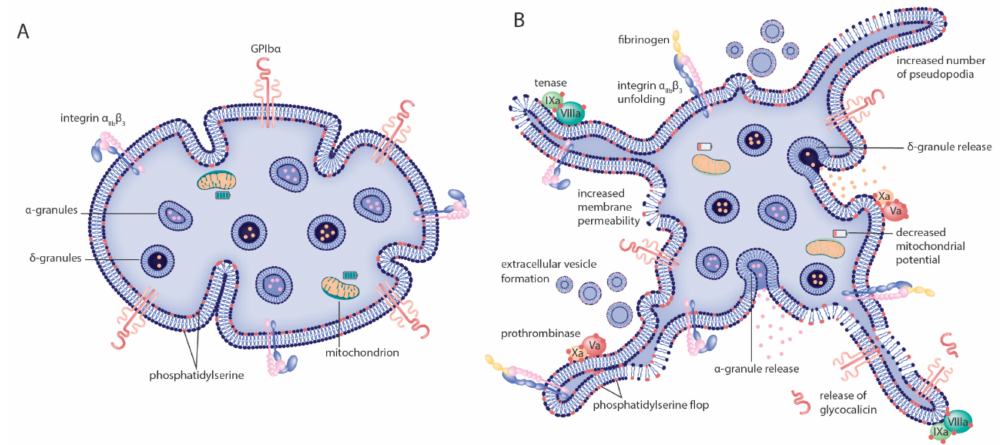
Figure 1. Morphologic and biochemical changes to platelets after cryopreservation. The model indicates known morphologic and biochemical changes to platelets going from ( A ) resting, healthy cells before cryopreservation to ( B ) altered phenotype after cryopreservation. Morphologic alterations induced by cryopreservation include a significant shape change from discoid to spherical platelets and increased numbers of platelet pseudopodia. Main changes to the cytoplasmatic membrane are increased permeability, extracellular vesicle formation and phosphatidylserine flop from the inner to the outer part of the bilayer. The latter two catalyze fibrin formation by providing a binding surface for the tenase and prothrombinase coagulation factor complexes. Many platelet surface receptors are expressed di ff erently after cryopreservation. P-selectin expression is increased, GPIb α expression is decreased and the integrin α IIb β 3 is (in part) activated each marking events of granule content release, receptor ectodomain shedding and fibrinogen binding, respectively. Finally, metabolic changes are detected by defective mitochondrial